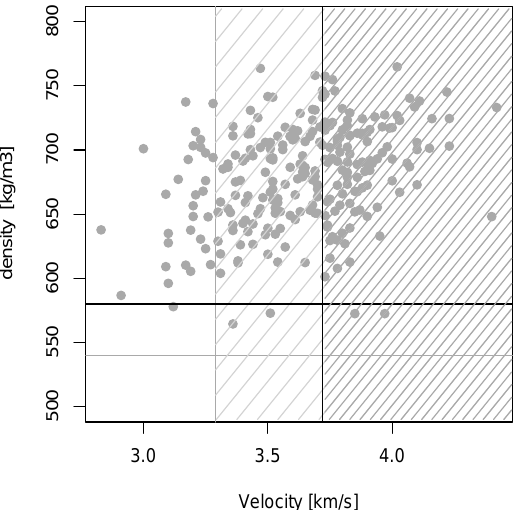
Figure 5. Scatterplot of density vs. velocity measured on wet timber and not adjusted for moisture content. Vertical lines = settings recalculated at 40% MC for D35 (grey) and D45 (black); horizontal lines = characteristics values of density for the classes D35 (grey) and D45 (black); sparse oblique lines = pieces assigned to D35; dense oblique lines = pieces assigned to D45.